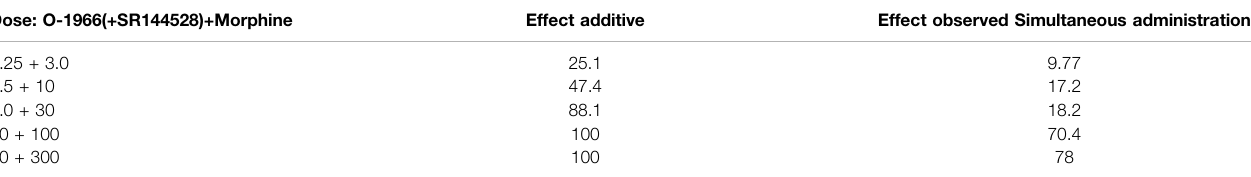
TABLE 1 | Predicted additive and actual observed ED50 values for simultaneous administration of O-1966, SR144528, and morphine combinations on acute antinociception on the hotplate. Dose: